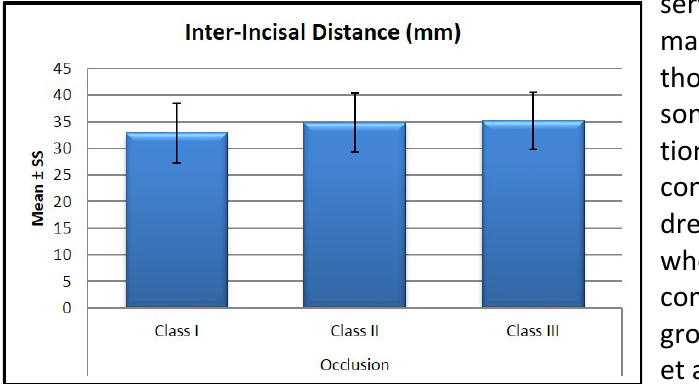
Figure 3. Mean maximum opening (mm) in different occlusion